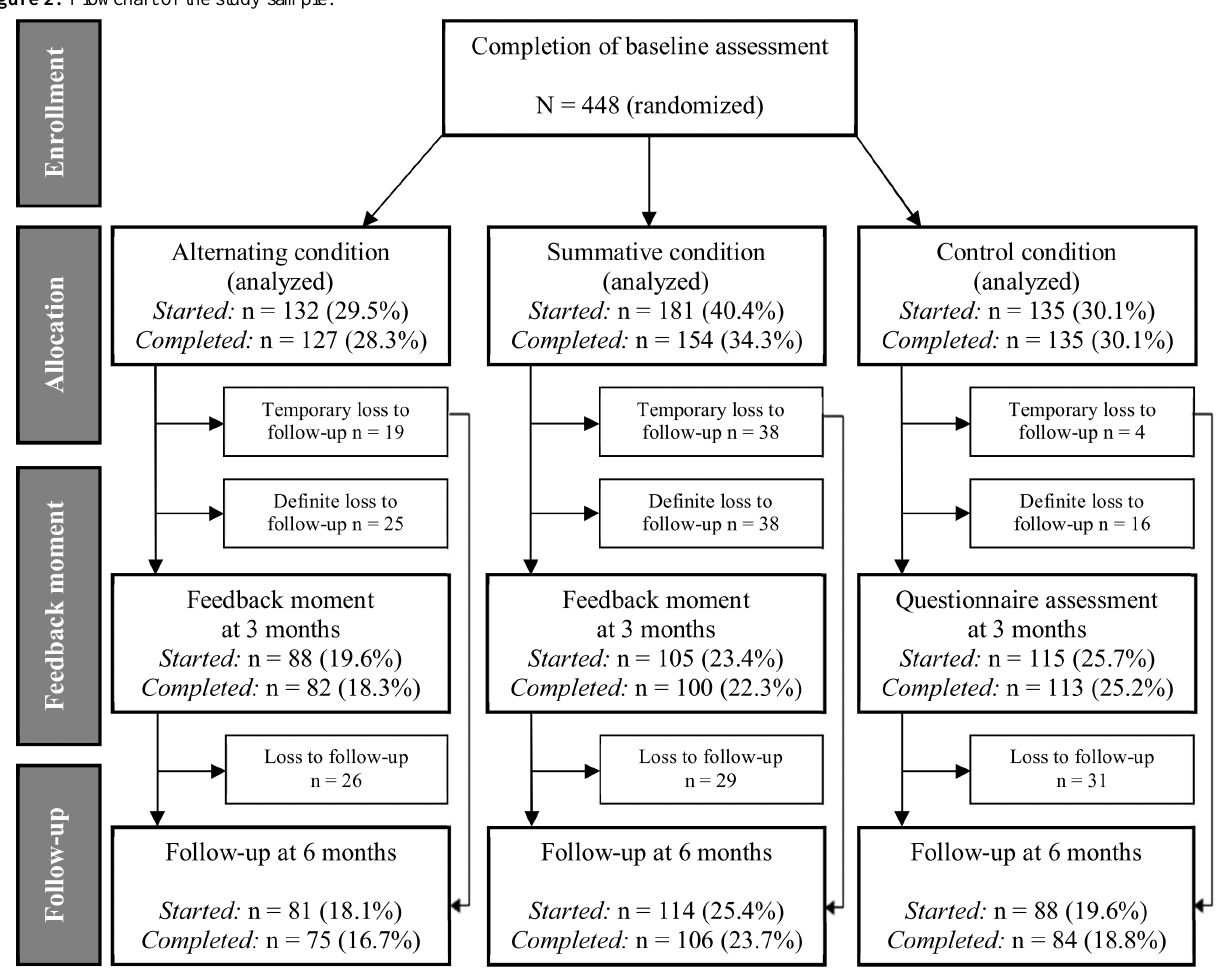
Figure 2. Flowchart of the study